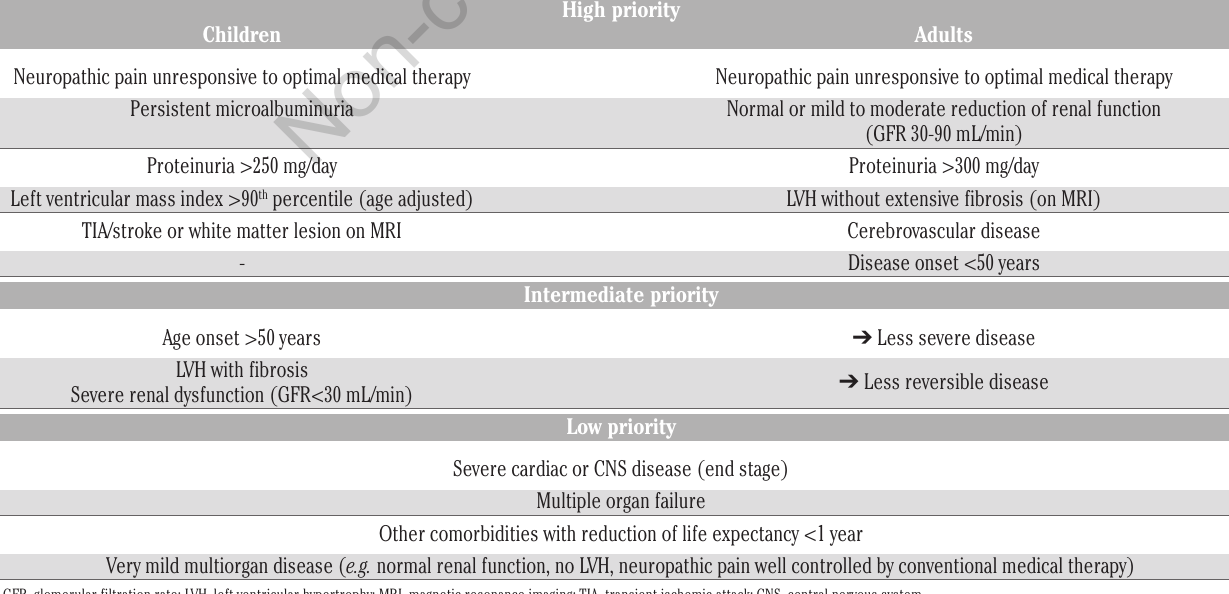
Table 2. Priority stages for treatment in naïve male and female patients with Anderson-Fabry